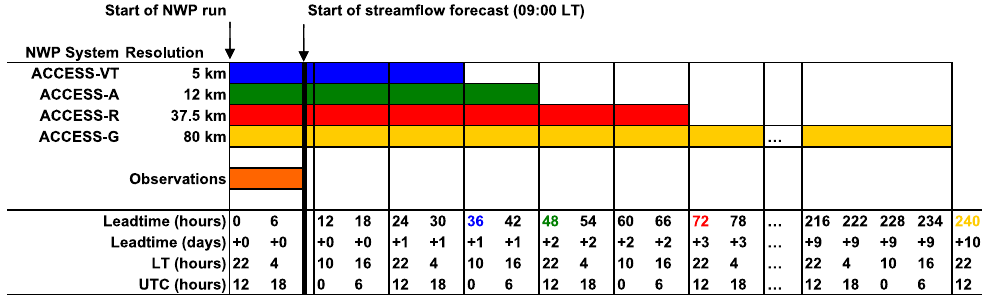
Fig. 2. Schematic of NWP model runs.